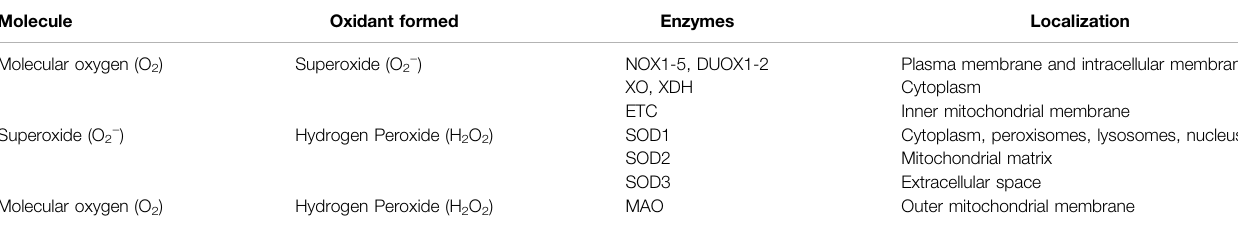
TABLE 1 | Source and localization of reactive oxygen species